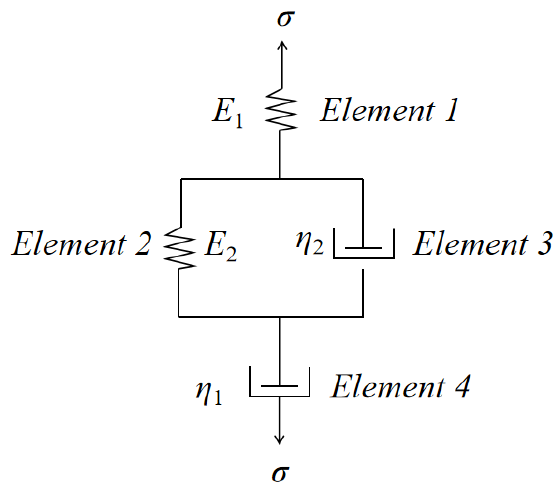
Figure 3. Burgers Figure 3. Burgers model.